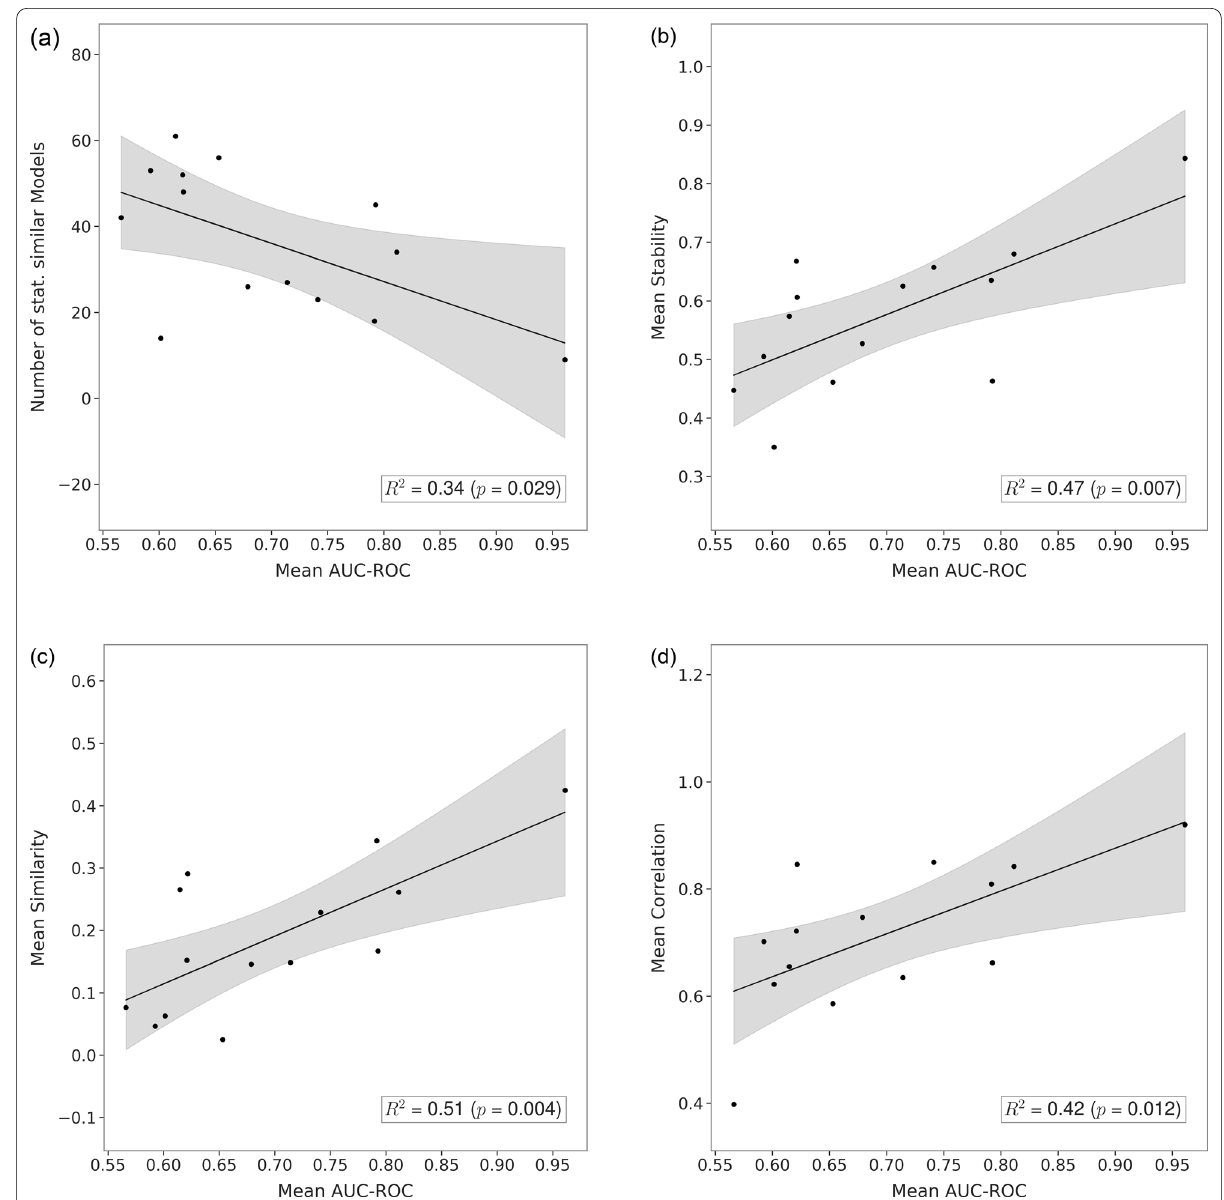
Fig. 5 Association of the mean AUC-ROC for all statistically similar models with ( a ) the number of equivalent models, ( b ) stability, ( c ) similarity and ( d ) correlation. Each point represents one